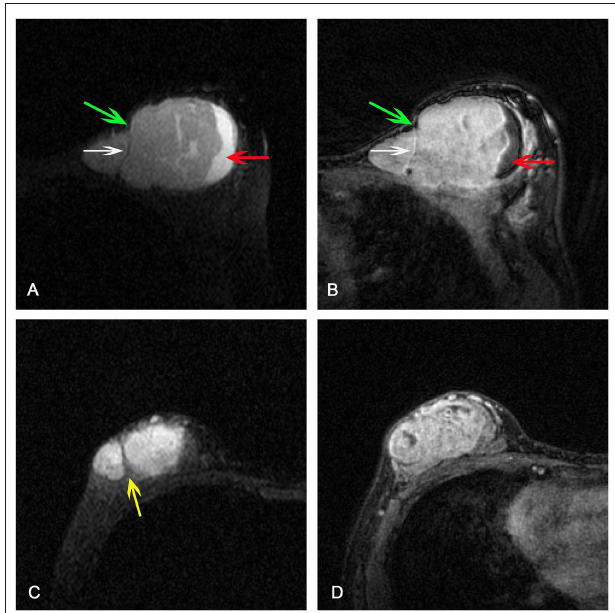
FIGURE 1 | (A) Axial short TI inversion recovery T2-weighted (T2W-STIR) and (B) third post-contrast image showing a mass with cystic component (red arrow), weak lobulation with obtuse angle (green arrows), septation (white arrow), and heterogeneous enhancement. Strong lobulation with acute angle (yellow arrow) was detected on (C) T2W-STIR and heterogeneous enhancement was detected on (D) third post-contrast image.